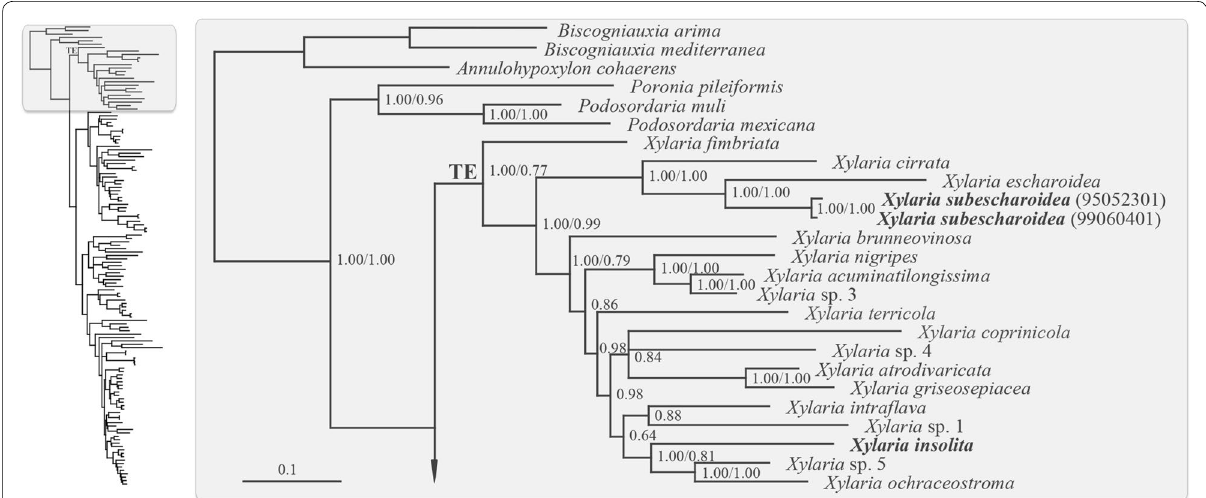
Fig. 2 Phylogenetic tree generated by BA analysis from the RPB2‑TUB‑ACT dataset. The complete tree is shown schematically, with the area in the rectangle enlarged to show the detail of the clade denoted by TE, which encompasses X. insolita , X. subescharoidea , and Xylaria species associated with termite nests or soil. Numbers at internodes represent posterior probability values of a 50% majority rule consensus tree from a 1,000,000 generation Markov chain Monte Carlo analysis. These are immediately followed by the bootstrap values greater than